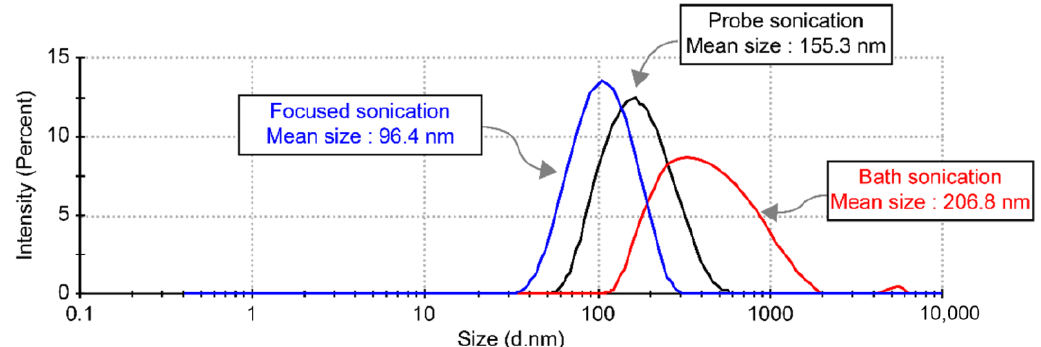
Figure 3. Size distribution of TiO 2 nanoparticles in deionized water based on sonication type.